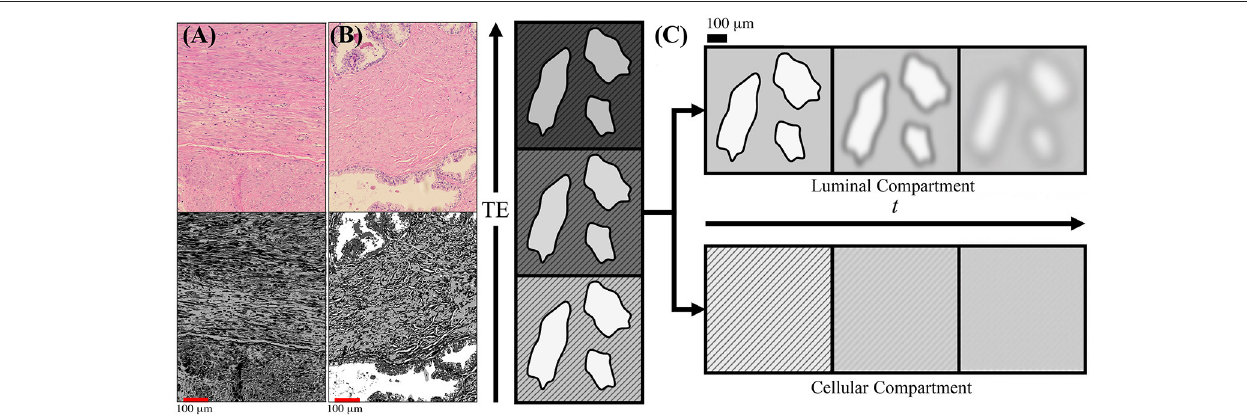
FIGURE 1 | Schematic of prostate microstructure and coarse-graining. H&E stained cross sections are shown from a radical prostatectomy (A,B) . To emphasize the structures and orientations, K-means clustering was applied onto the H&E images to emphasize the different intra-voxel compartrments and stromal orientations. In (A) we show that there is considerable structural anisotropy and local coherence in stromal cell orientation. There is an apparent directionality as certain fiber bundles of smooth muscle appear in both perpendicular and longitudinal cross sections within the a 1,000 784 µ m 2 section. In (B) we show that stroma and glandular × lumen can reside very close to each other, therefore the signal contribution from a voxel will be a weighted average depending on various tissue weightings. (C) As the echo time ( T E ) increases, the cellular compartment (stripes) decays with a faster T 2 , while the luminal compartment (solids) decays with a slower T 2 . By modeling the T 2 weighting of each compartment, the signal weighting, W , of each tissue subtype can be determined based on the diffusion-free signal, S 0 , cellular compartment fraction, f , and relaxation parameters T 1 , T C 2 , and T L 2 . Given the compartment weights, the overall diffusion tensor may be subsequently separated into cellular-only and lumen-only tensors. Once tissue compartments are separated, the evolution of D ( t ) in each tissue compartment can be interpreted through the context of the √ D ( t ) t , which increases underlying microstructure. Diffusing molecules “see” the compartmental microstructure through the lens of a Gaussian filter of width L ( t ) ∼ with t